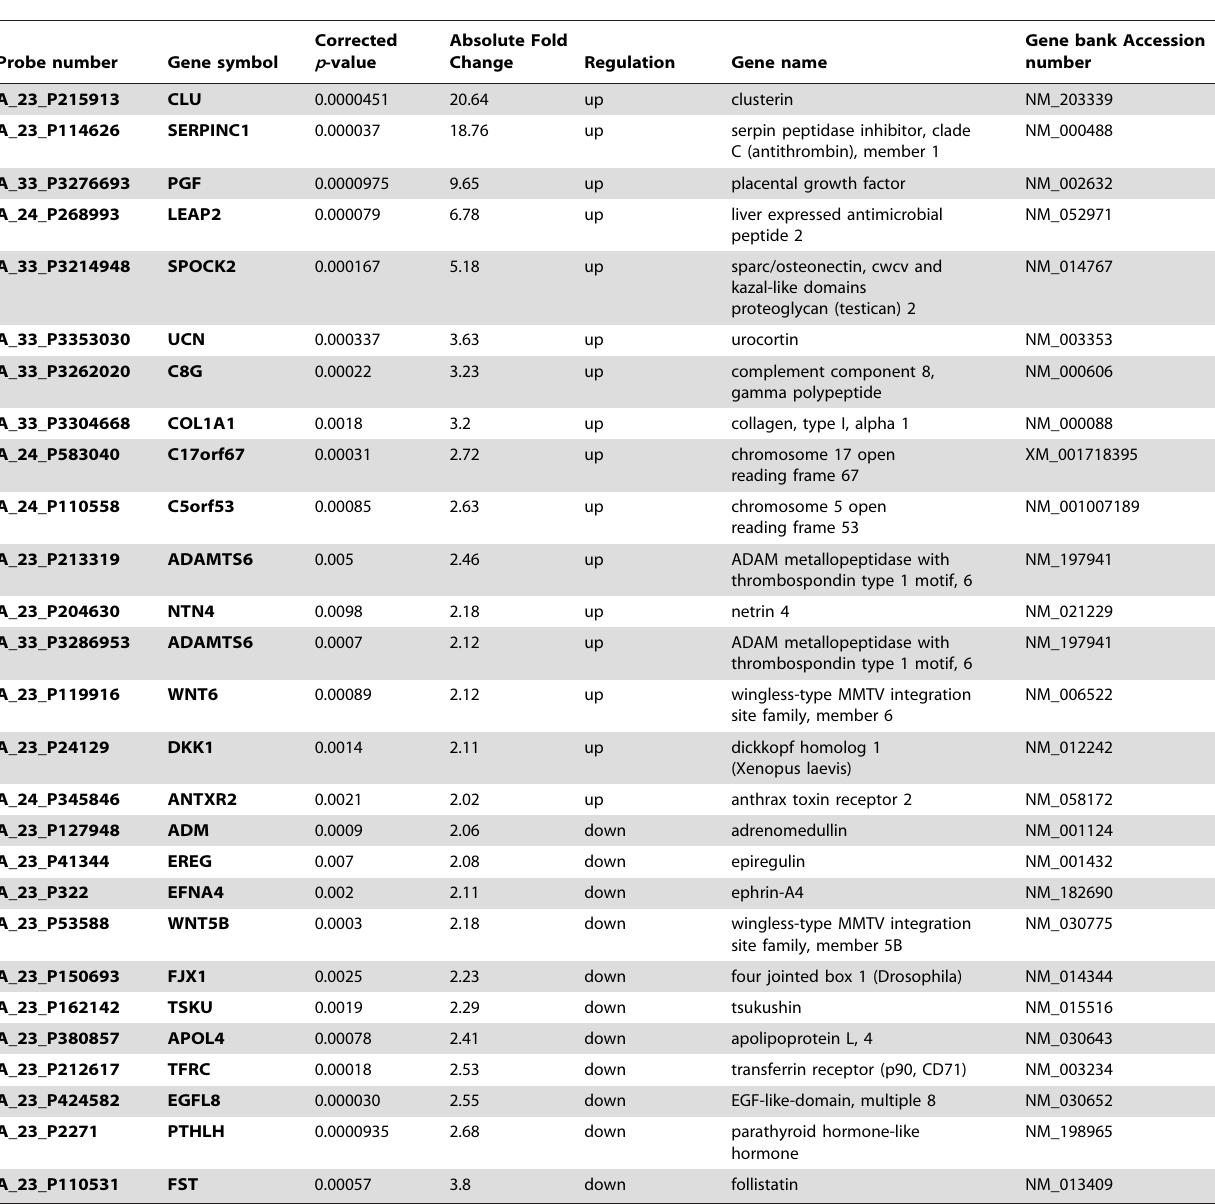
Table 2. Secreted factors statistically differentially expressed between Sham and Expo.